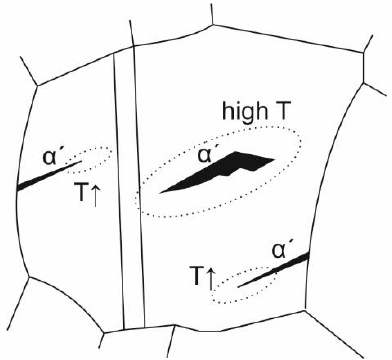
Fig. 2. Schematic illustration of the hypothesized inhibition mechanism of α ´-transformation at high strain rates: increased slip activity and heat release from the phase transformation increase the local temperature (T) in the microstructure and suppress further nucleation and coalescence of martensite